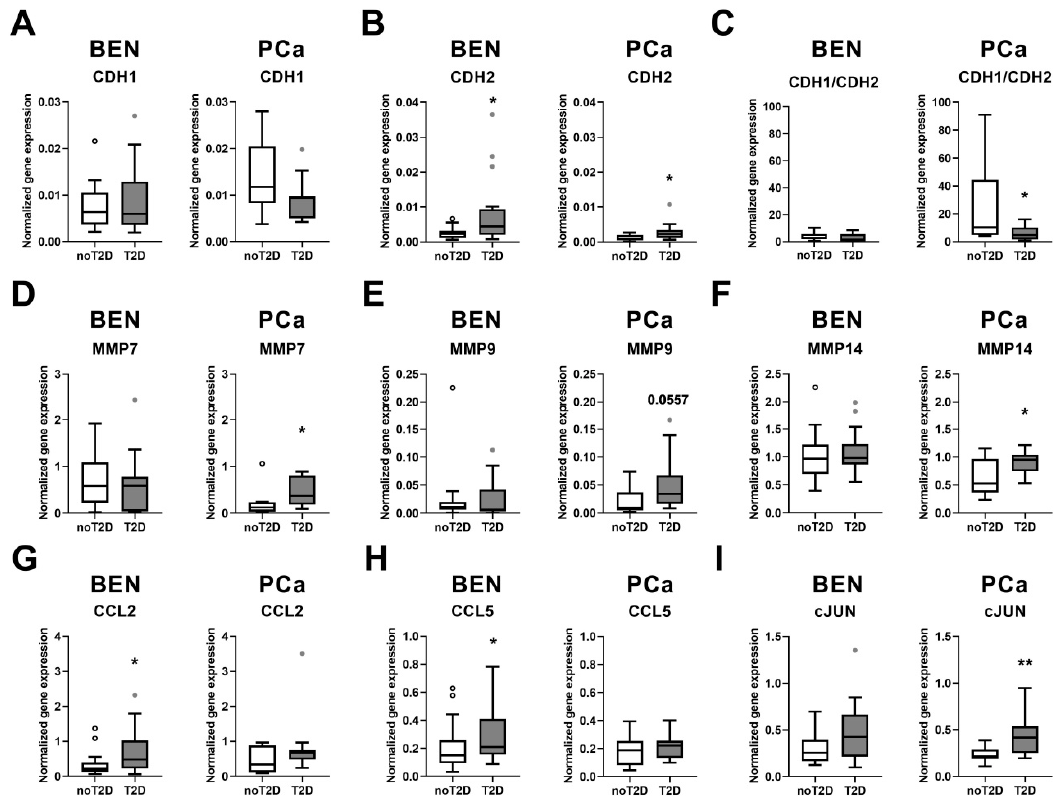
Figure 2. Gene expression levels of indicated genes were quantified in benign prostate (BEN) (n = 17–17) and prostate cancer (PCa) (n = 11–11) tissues of PCa patients with (T2D) and patients without (noT2D) type 2 diabetes. ( A ) CDH1, ( B ) CDH2, ( C ) CDH1 / CDH2 ratio, ( D ) MMP7, ( E ) MMP9, ( F ) MMP14, ( G ) CCL2, ( H ) CCL5, ( I ) cJUN. Data are shown as Tukey box plots. White and grey dots denote individual values, which were higher than the sum of the 75th percentile plus 1.5-times inter-quartile range. Statistical significance was calculated using Mann–Whitney tests and considered as p < 0.05.